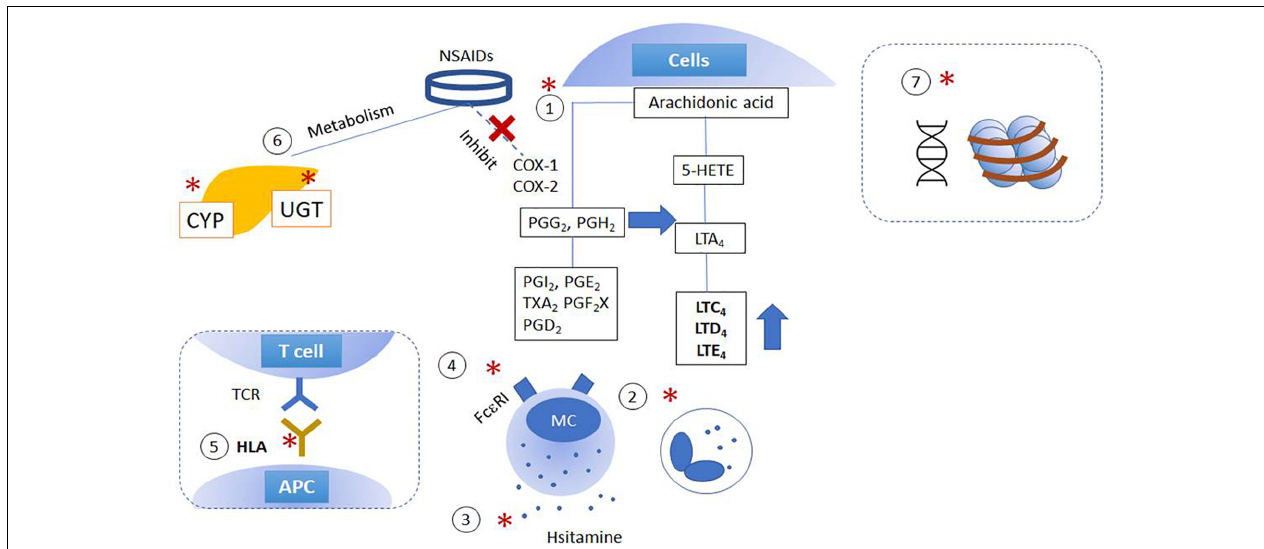
FIGURE 1 | Schematic figures of genetic and epigenetic mechanisms of NSAID hypersensitivity. Genetic effects are suggested to affect (1) arachidonic acid/cyclooxygenase pathway; (2) cytokine and intracellular activation/inactivation signaling of inflammatory cells; (3) histamine/adenosine metabolism; (4) activation of IgE receptors, and (5) HLA and MHC class II. Moreover, further studies report the involvement of (6) mutations in enzymes involved in drug metabolism and (7) epigenetic alterations. (X): NSAIDs inhibit COX enzymes; (*) indicated the pathways which are intervened by NSAIDs. APC, antigen-presenting cells; COX, cyclooxygenase; CYP, cytochrome P450; HETE, hydroxyeicosatetraenoic acid; LT, cysteinyl leukotrienes; NSAID, non-steroidal anti-inflammatory drugs; MC, mast cells; PG, prostaglandins; TX, thromboxane; UGT,